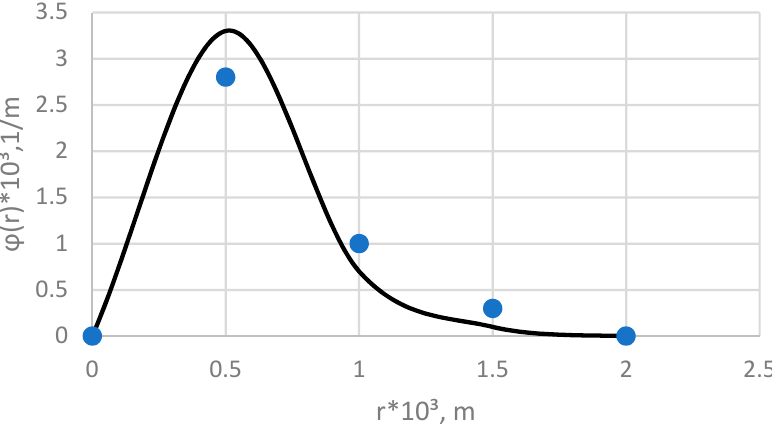
Figure 3. Dependence of the differential particle size distribution function. The line represents calculated values, the points—experimental values.